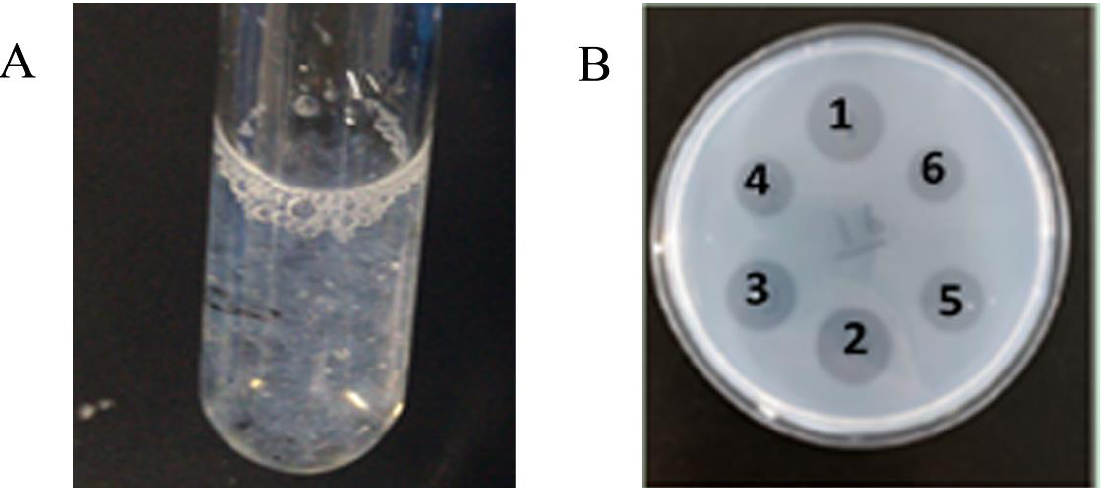
Figure 2. Bioassays of thrombolytic potency. ( A ) The thrombolytic potency was evaluated by the Bubble-rising method. ( B ) The thrombolytic potency was evaluated by the Agarose-fibrin plate method (n = 3). 1. 800 U/mL UK standard; 2. 600 U/mL UK standard; 3. 400 U/mL UK standard; 4. 200 U/mL UK standard; 5. UK/PD-RGDS complex; 6. The UK.